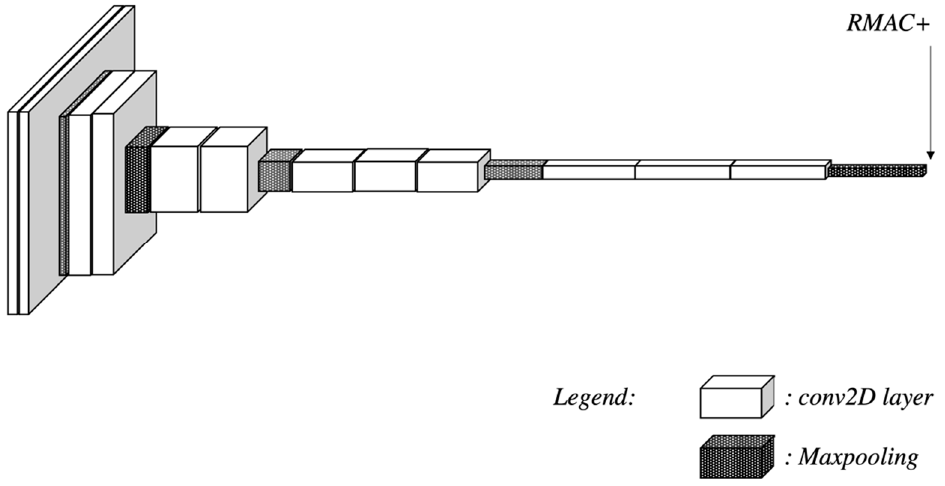
Figure 12. Illustration of RMAC+ position on VGG16 architecture.